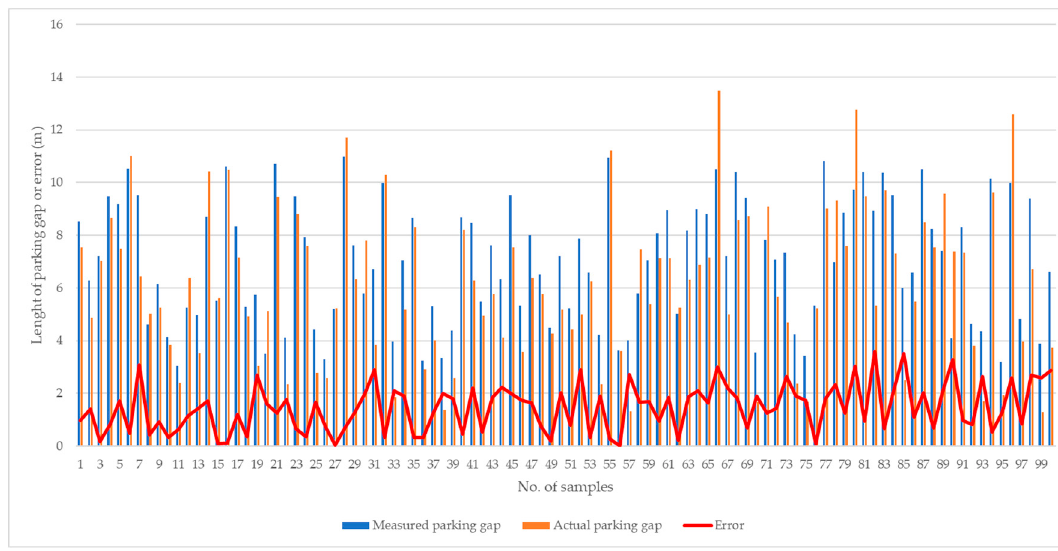
Figure 19. Accuracy comparison for parking-gap measurement.